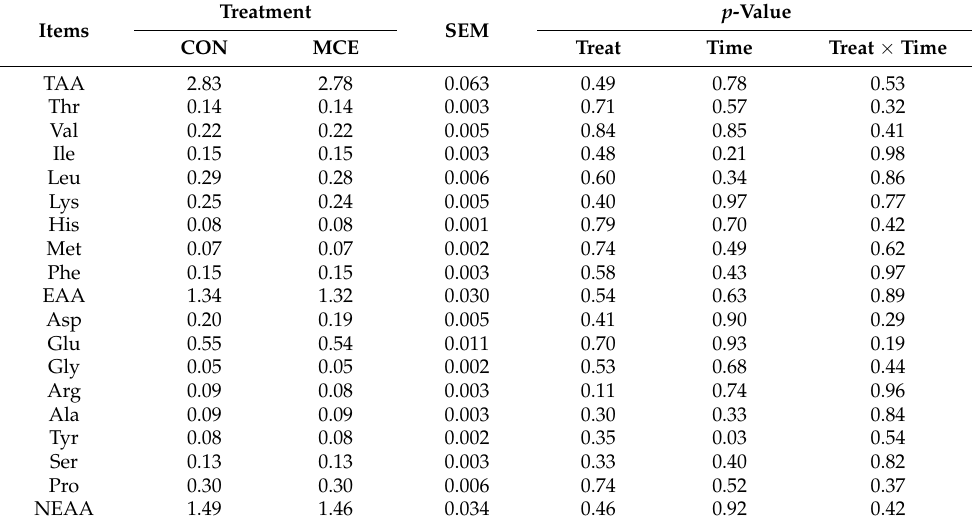
Table 5. Effect of MCE on milk amino acid composition (g/100 g).